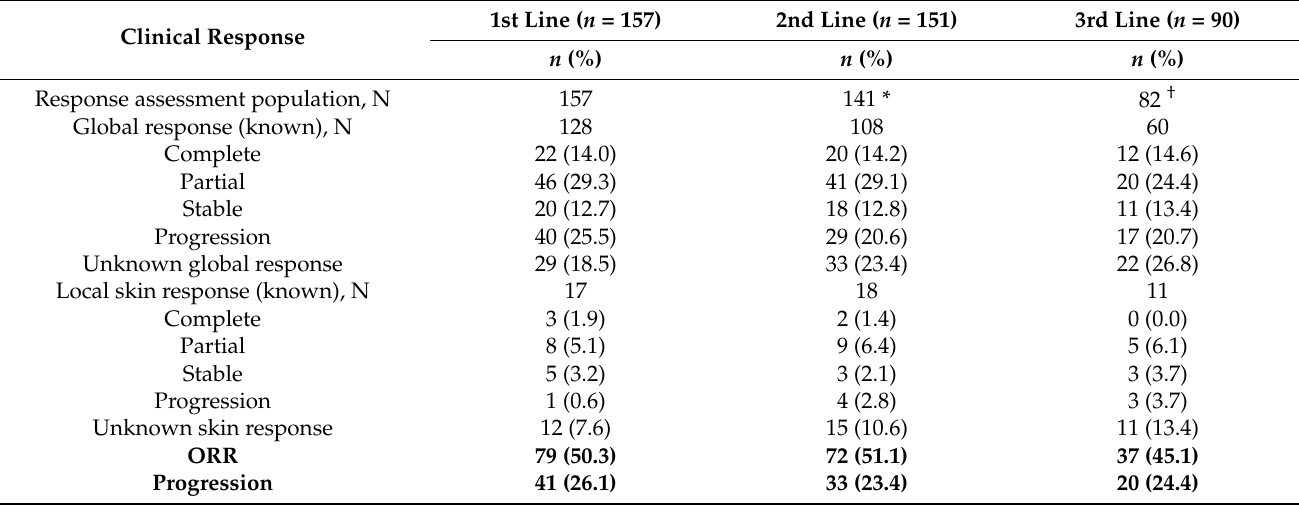
Table 5. Response to systemic therapy in 1st, 2nd and 3rd